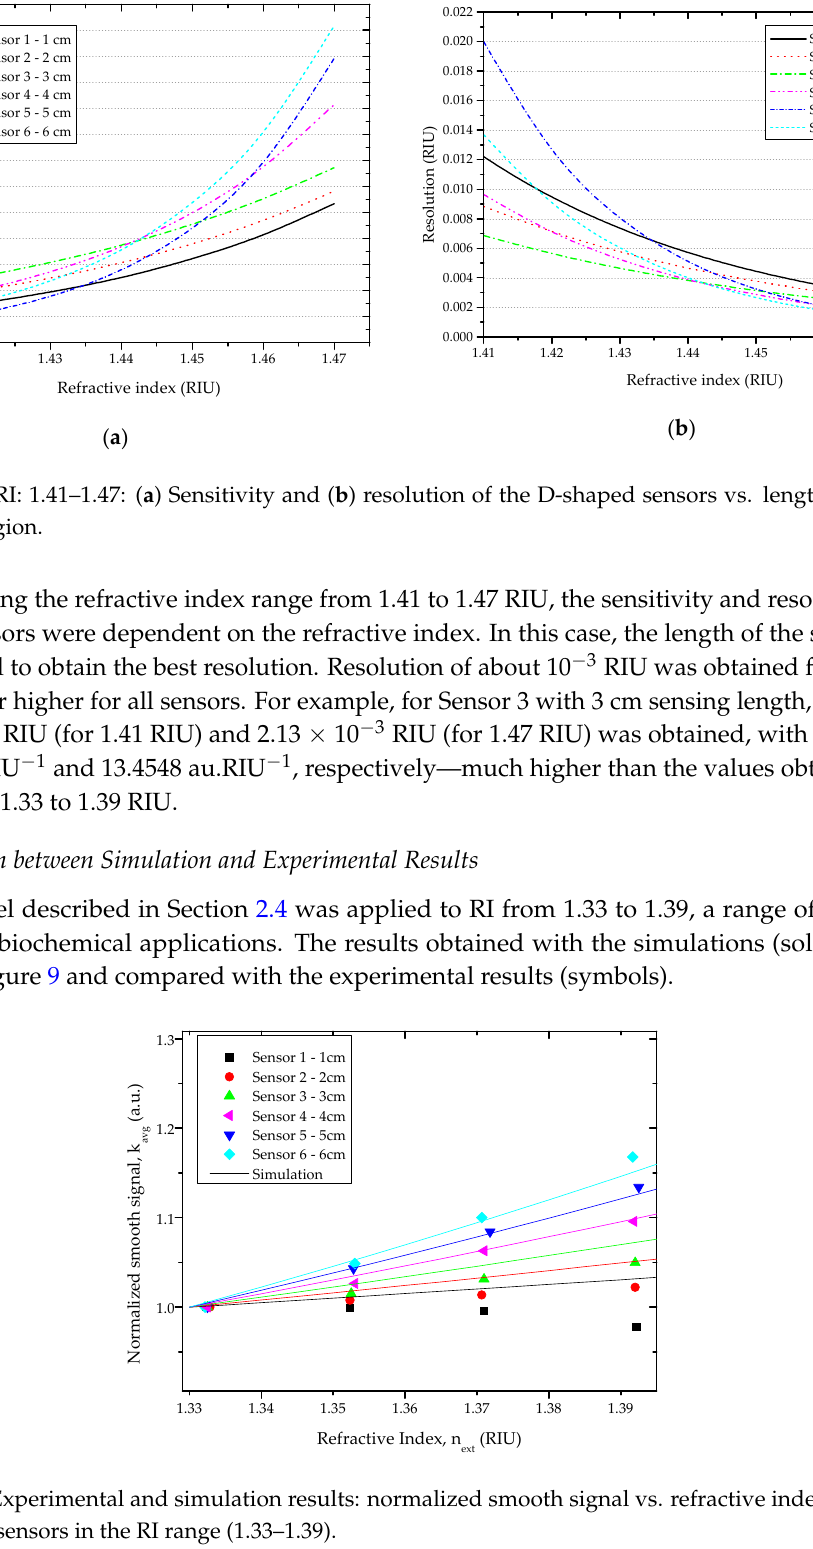
Figure 9. Experimental and simulation results: normalized smooth signal vs. refractive index for all D-shaped sensors in the RI range (1.33–1.39).